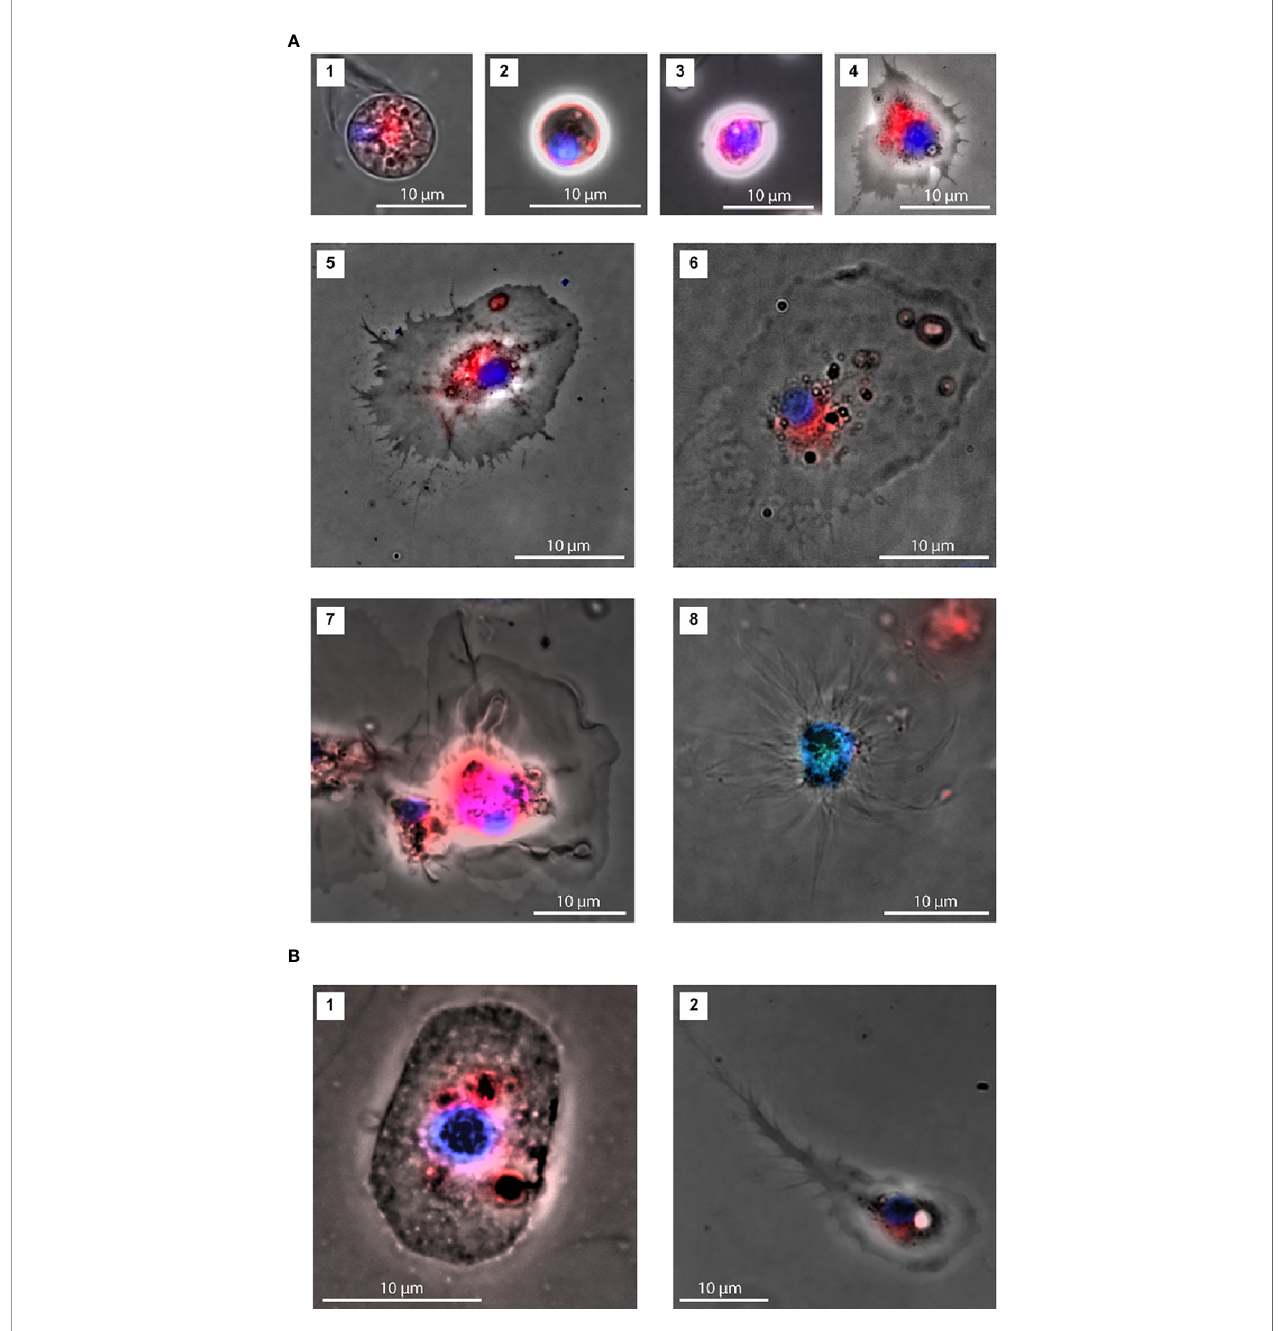
FIGURE 5 | Characterization of coelomocytes morphologies by fl uorescence microscopy. (A) Two morphotypes were identi fi ed within the P1 cell population: cells with a lower nucleus to cytoplasm ratio ( 1 ; area: 78 m m 2 and 2. area: 26 m m 2 ) and cells with a nucleus occupying most of the cell space ( 3 ; area: 39 m m 2 ). Three morphotypes were observed within the P2 cell population: Regular ( 4 ; area: 130 m m 2 , 5 ; area: 354 m m 2 and 6 ; area: 430 m m 2 ), Petaloid ( 7 ; area: 561 m m 2 ) and Filopodial ( 8 ; area: 463 m m 2 ). (B) Representatives of novel P2 cell morphologies ( 1 ; area: 167 m m 2 and 2. area: 171 m m 2